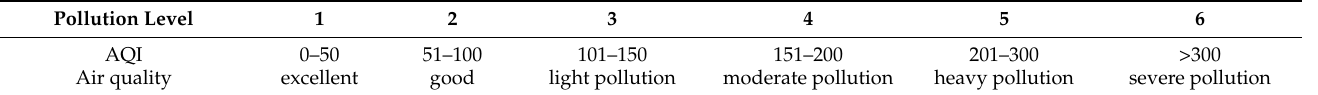
Table 2. AQI index of different grades.